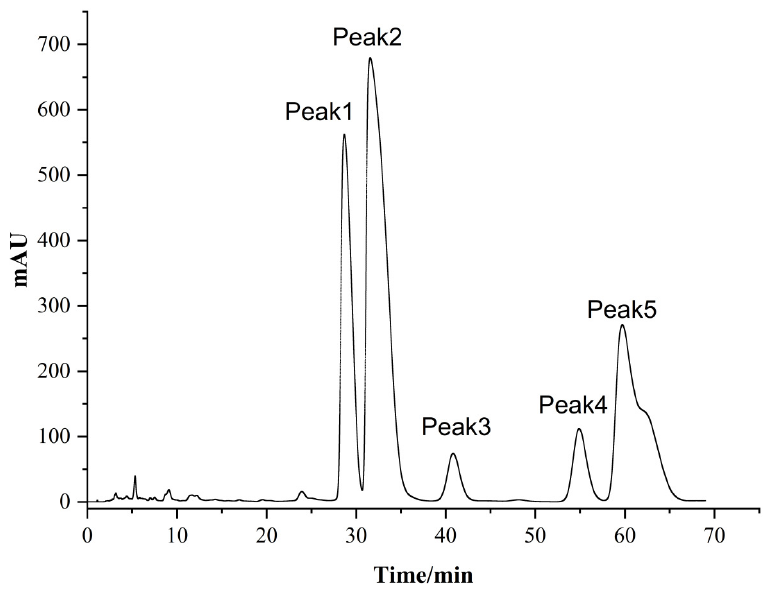
Figure 3. Preparative chromatogram of the ginkgols.